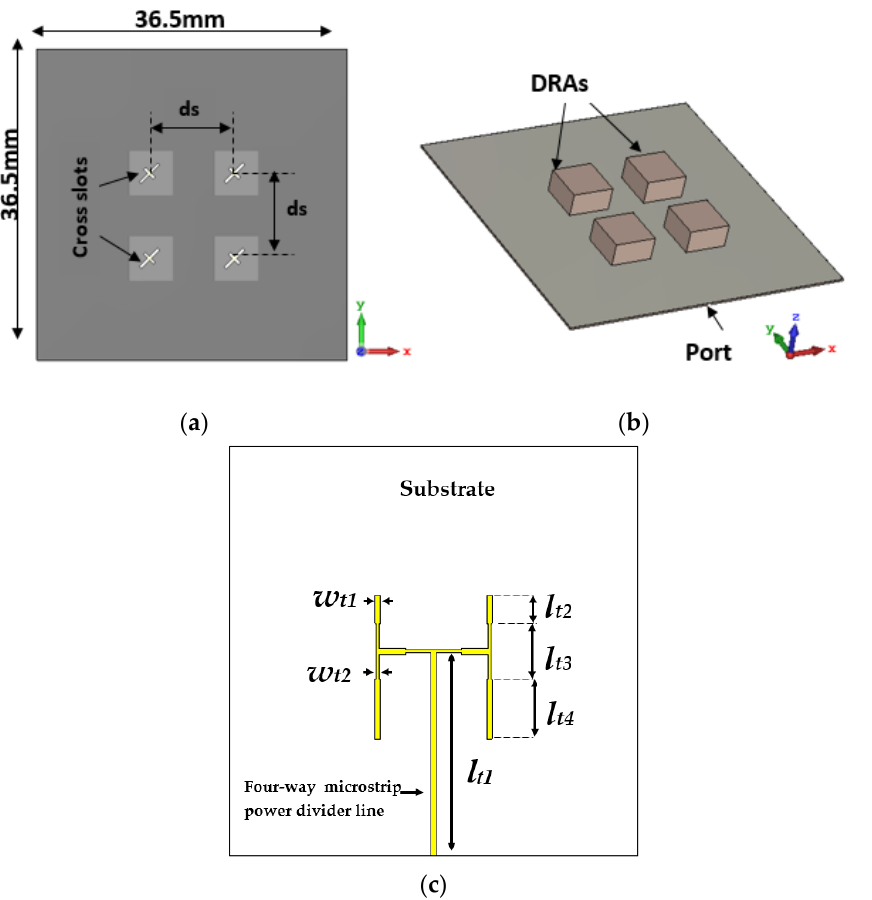
Figure 6. Configuration of the proposed DRA-array antenna ( a ) top view, ( b ) three-dimensional view and ( c ) feed network.